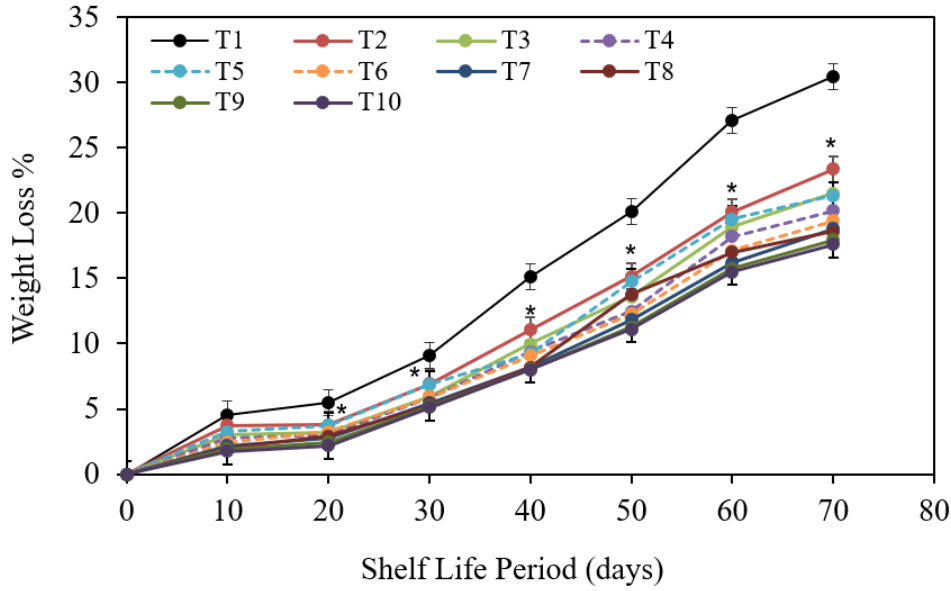
Figure 4. The impact of pre-harvest chitosan, chitosan nanoparticle, and CaCl 2 foliar spray treatments on weight loss of Barhi date fruits under cold storing for 70 d. Note that * sign denotes the significant differences between the control and edible coatings treatments, and T1, T2, T3, T4, T5, T6, T7, T8, T9, T10 are water (control), 1 g/L chitosan, 2 g/L chitosan, 3 g/L chitosan, 1 g/L chitosan nanoparticles, 2 g/L chitosan nanoparticles, 3 g/L chitosan nanoparticles treatments,